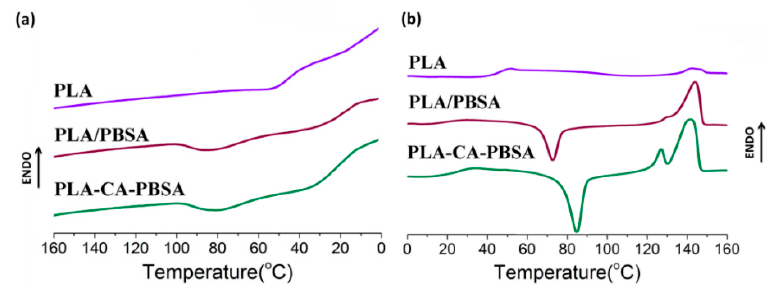
Figure 2. DSC trace of PLA, PLA/PBSA and PLA-CA-PBSA during ( a ) cooling and ( b ) second heating scan. heating scan. Table 2. Thermal properties of PLA, PLA/PBSA and